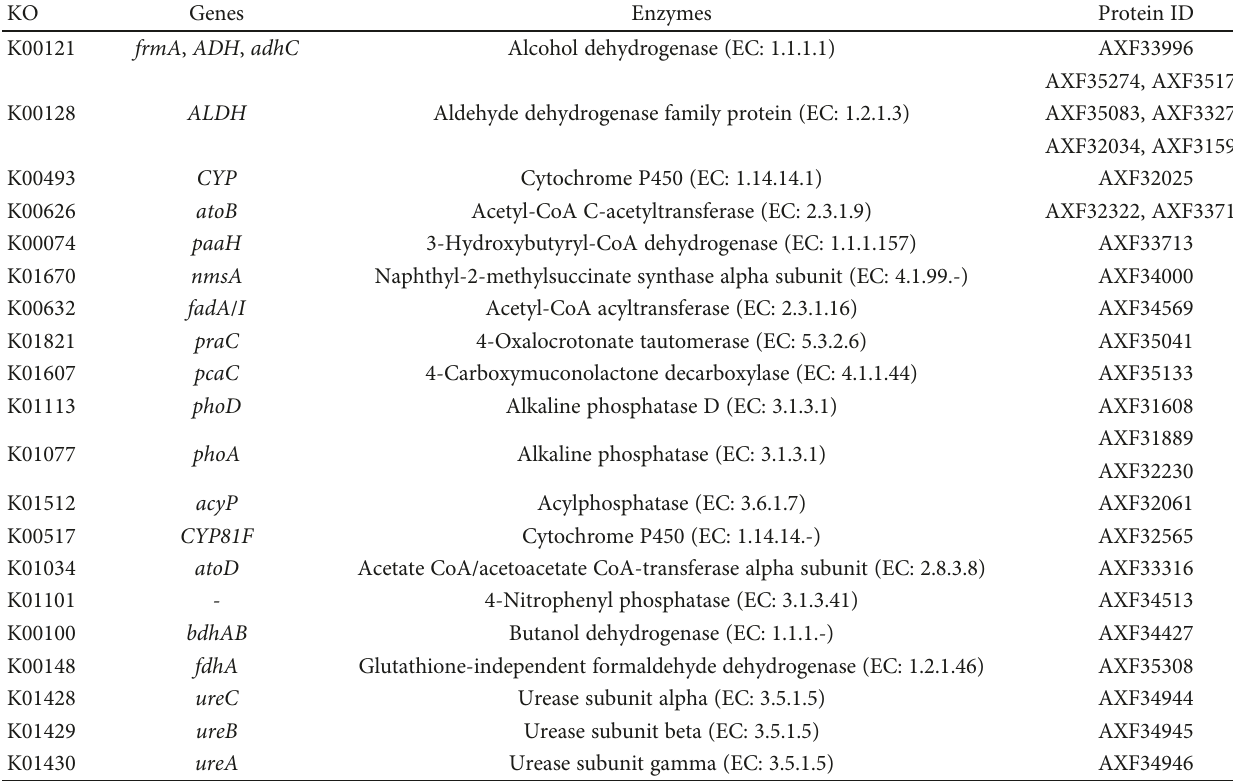
Table 6: List of KO pathways for hydrocarbon and aromatic compound